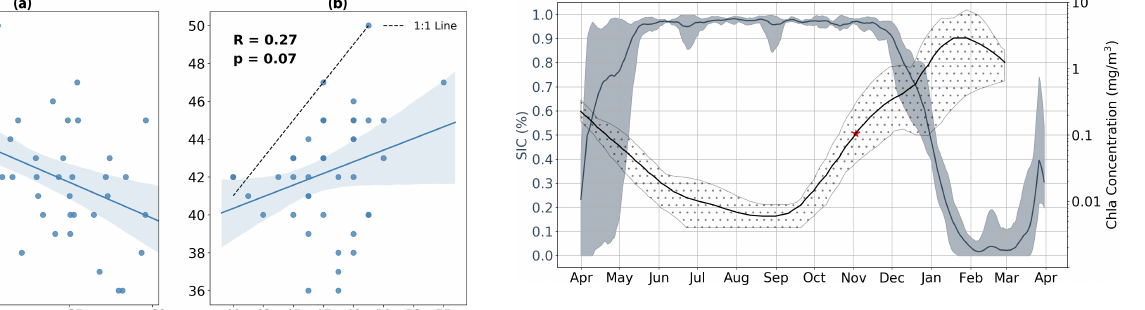
Figure 6. Satellite sea ice concentration (SIC) versus Argo float Chl a for region R75. Shaded regions around each line represent both the spatial and temporal variability present in each data set. That is, each bold line plots the mean value of five time series which are each associated with a specific melt event. Events are separated in space and time; in this particular case, 2017 and 2018 were sam- pled by three floats (see Table 1), which resulted in five time series (two each, with one of the floats only sampling in 2017). The red star represents the mean value of